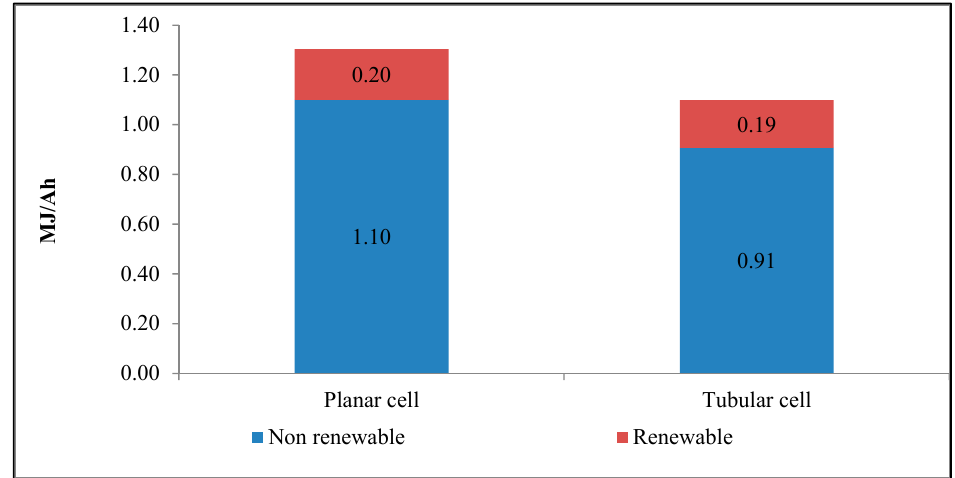
Figure 1. Cumulative energy demand of the two cell configurations (data for 1 Ah).